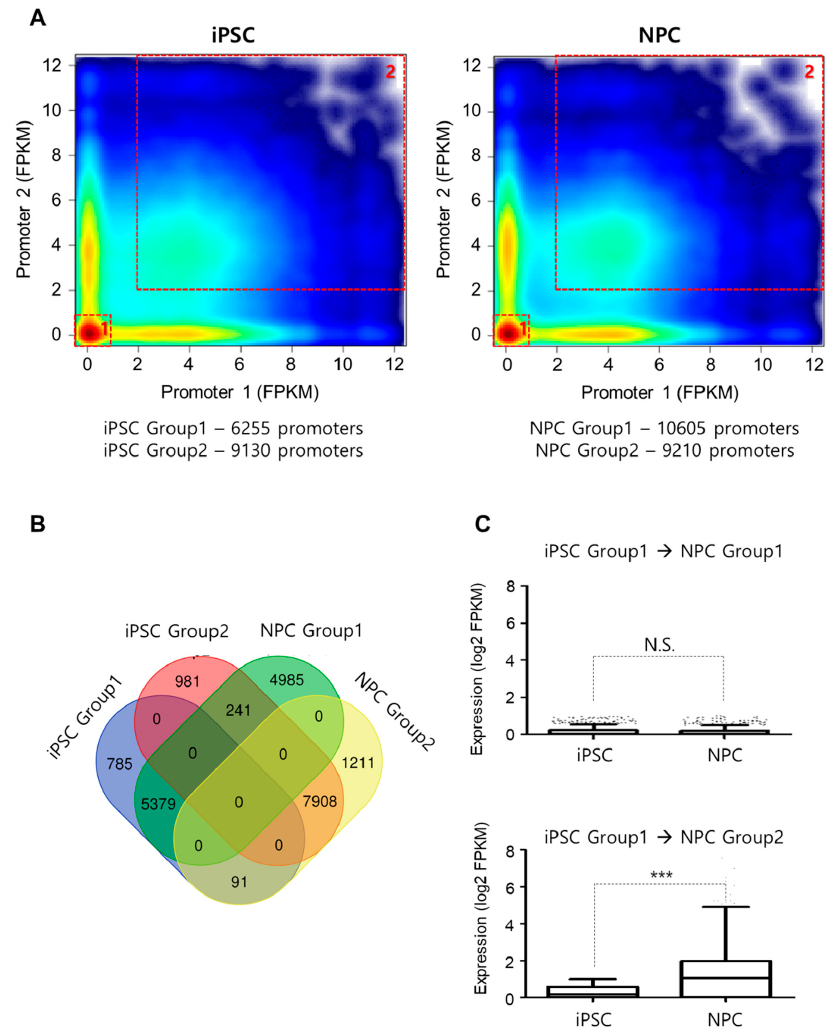
Figure 4. Role of promoter–promoter interactome in cellular identity program maintenance and development. ( A ) Correlation between promoter–promoter interactions and related gene expression shows formation of 2 distinct clusters in both iPSCs and NPCs, respectively—Group 1 (both promoter pairs suppressed, low FPKM) and Group 2 (both promoter pairs activated, high FPKM) enables the quick identification of current cell status. ( B ) The number of overlapping promoter–promoter interactions between groups. ( C ) Change in the expression level of genes (FPKM) shared between representative groups during differentiation. For all box-and-whisker plots, the horizontal lines in the boxes present the median value. The upper and lower error bars indicate the 90th and 10th percentiles, respectively. ***, p -value < 0.001 (unpaired t -test, Mann–Whitney test, two-tailed). 4. Discussion iPSCs are highly valued for their versatility in generating different cell types without the ethical concerns of human embryonic stem cells since adult somatic cells are used. This flexibility is appreciated to a great extent in the study of neurodegenerative disorders as diseased cells are challenging to obtain from patients. NPCs, namely precursor cells derived from iPSCs, also display great plasticity, which explains why they are the common platform from which various neurons are